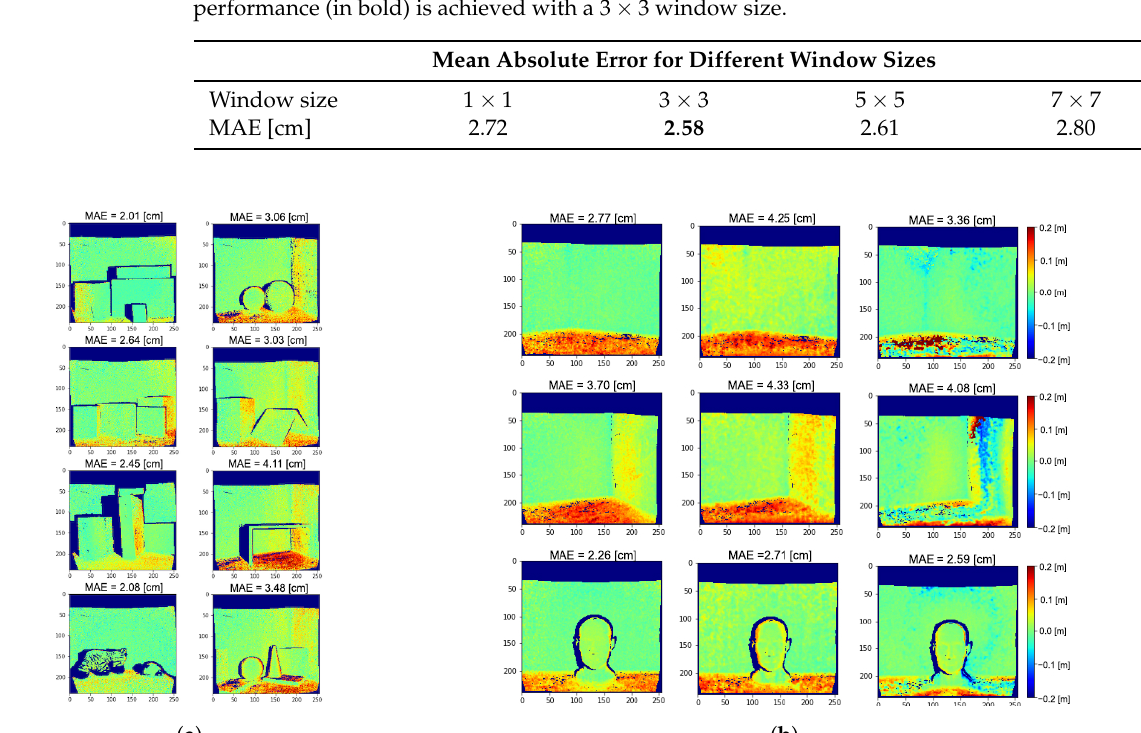
Figure 11. ( a ) Depth error maps on dataset S 3 obtained without spatial correlation. ( b ) Predicted depth error maps obtained with increasing kernel size on three real scenes, from left to right respectively P = 1, 2 and